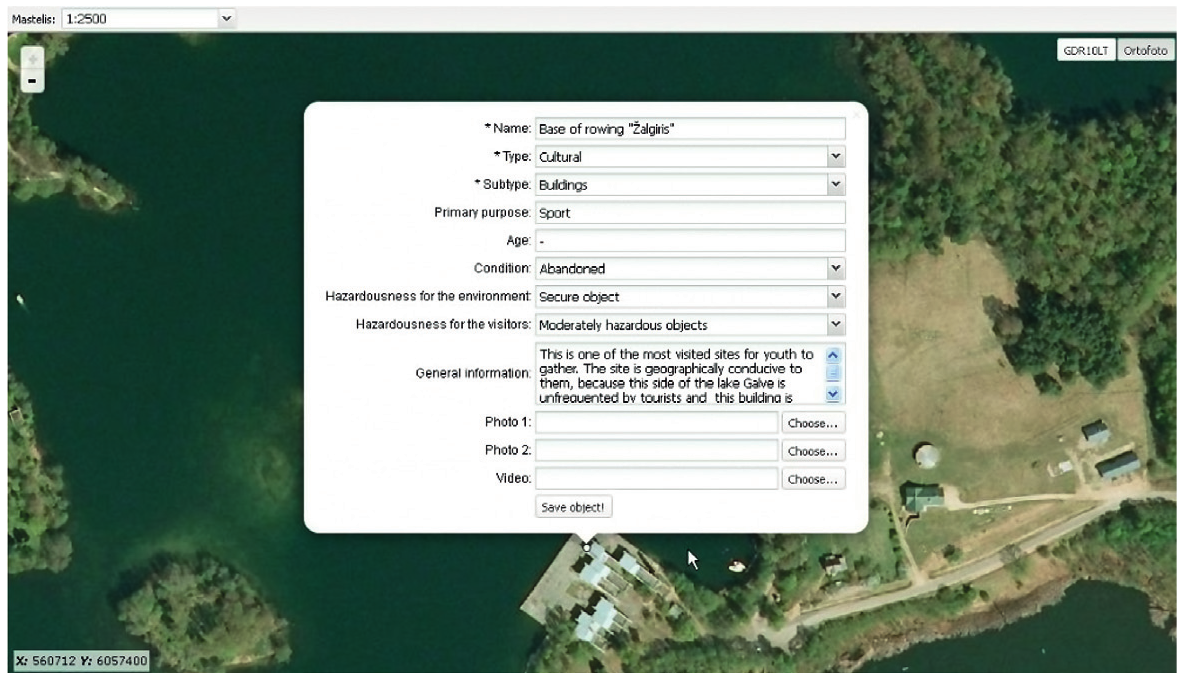
Fig. 3. User interface for entering an object or site on the interactive map. For example, the rowing club Žalgiris in